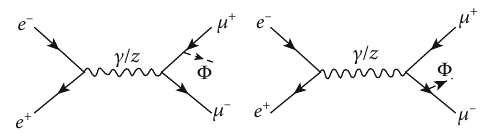
Figure 6: The dominant tree-level contributions to e + e − → μ + μ − ϕ